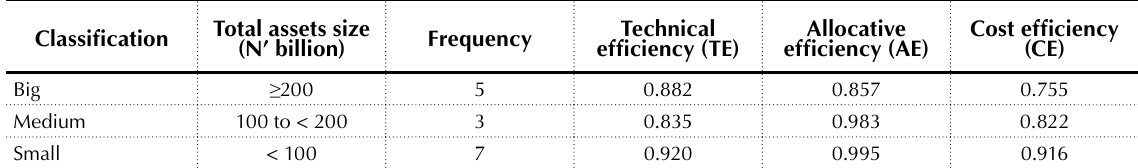
Source: authors’ computation.